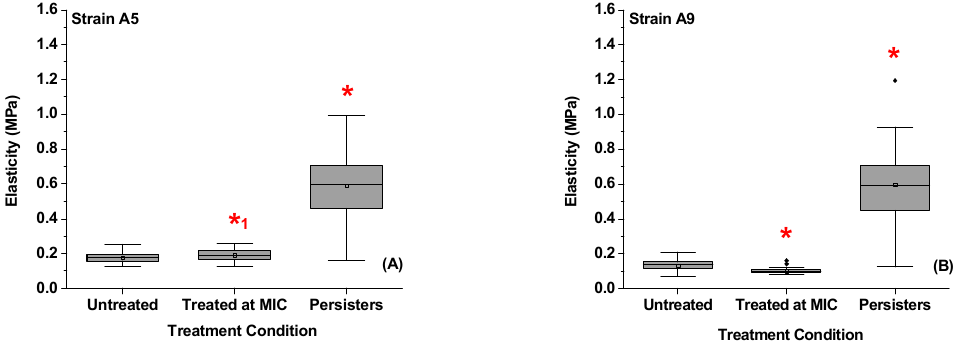
Figure 8. ( A , B ) A summary of the average bacterial cell elasticities quantified for Strains A5 and A9, respectively by Hertz model described in Equation (2) for different treatments. * Values are statistically significant between the untreated and treated cells. * 1 Values are statistically significant from the treated group but not from the untreated group, p < 0.001, n = 3 independent cultures.